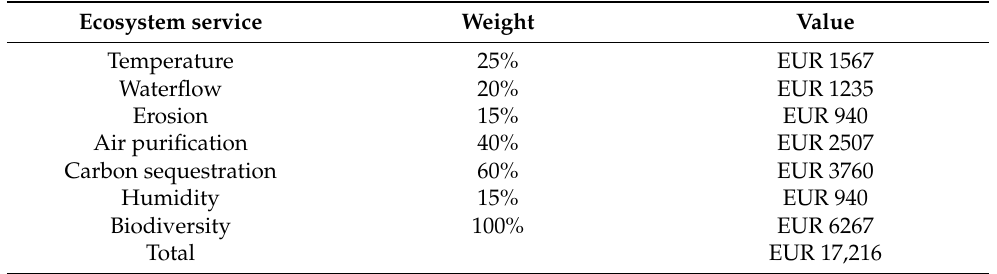
Table 1. Maximum contribution of ecosystem services per ha (adapted from Krzemie´n et al. [1]).